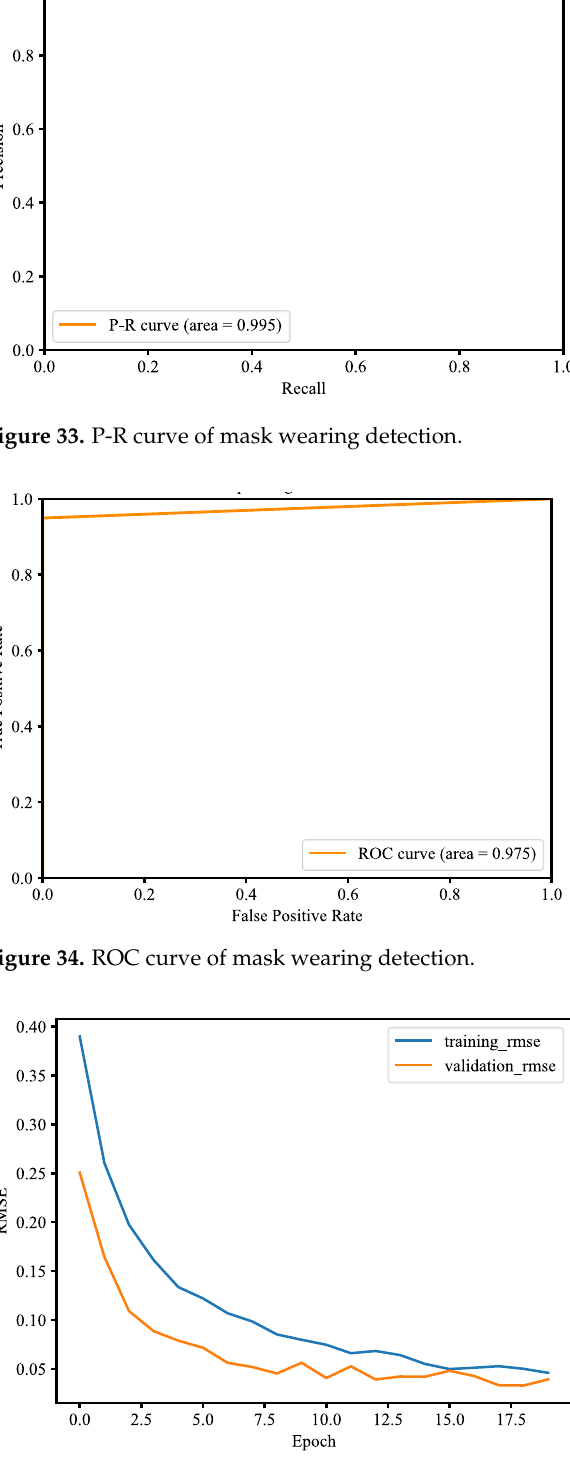
Figure 35. RMSE of mask wearing detection.